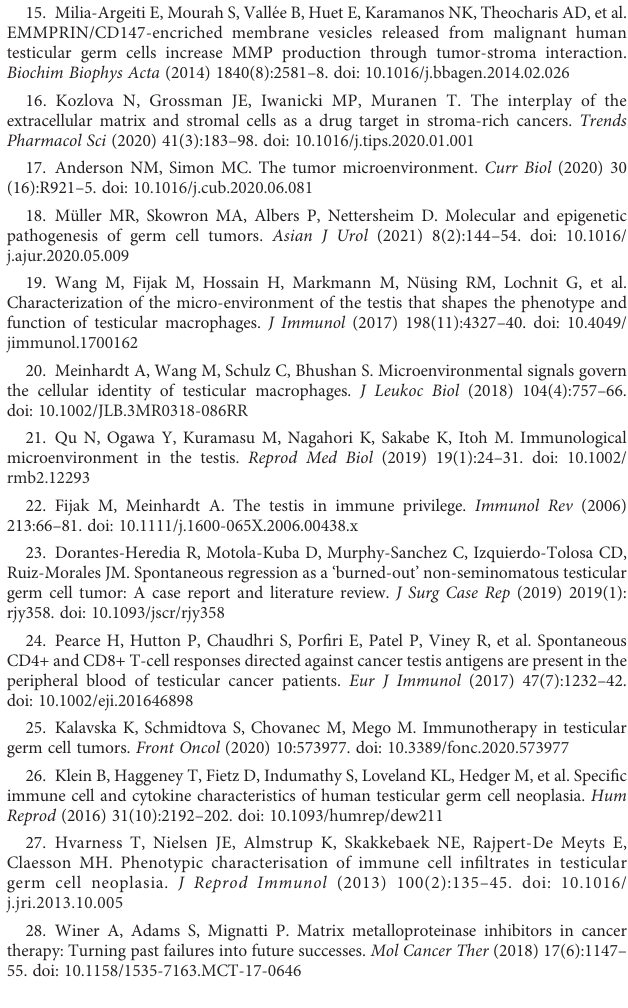
Figure 1 has been created with Biorender.com (https://biorender.